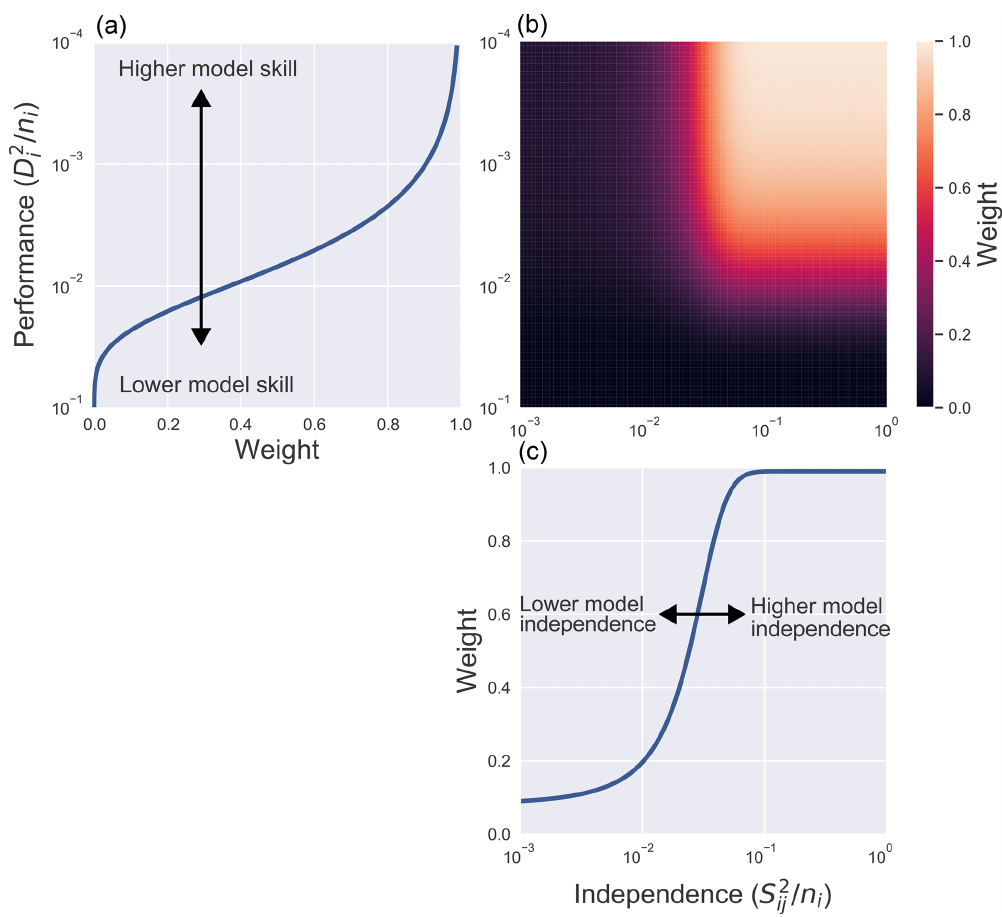
Figure 1. Panel (a) shows the overall weighting function w i (Eq. 1), plotted for 11 models ( N = 11) with σ D = 0 . 1 and σ S = 0 . 1. Panel (b) /n i = 1), and panel (c) shows the contribution due to model shows the contribution to the weighting due to model performance (at S 2 ij /n i = 10 − 4 ). A model which has higher independence and higher skill receives a larger weight. For the weight due to independence (at D 2 i /n i = σ 2 performance (a) we can see that the weight equals e − 1 when D 2 . This shows how σ D acts as a length scale that determines how D i close a model has to be to observations to receive weight. σ S works similarly, setting the length scale that determines